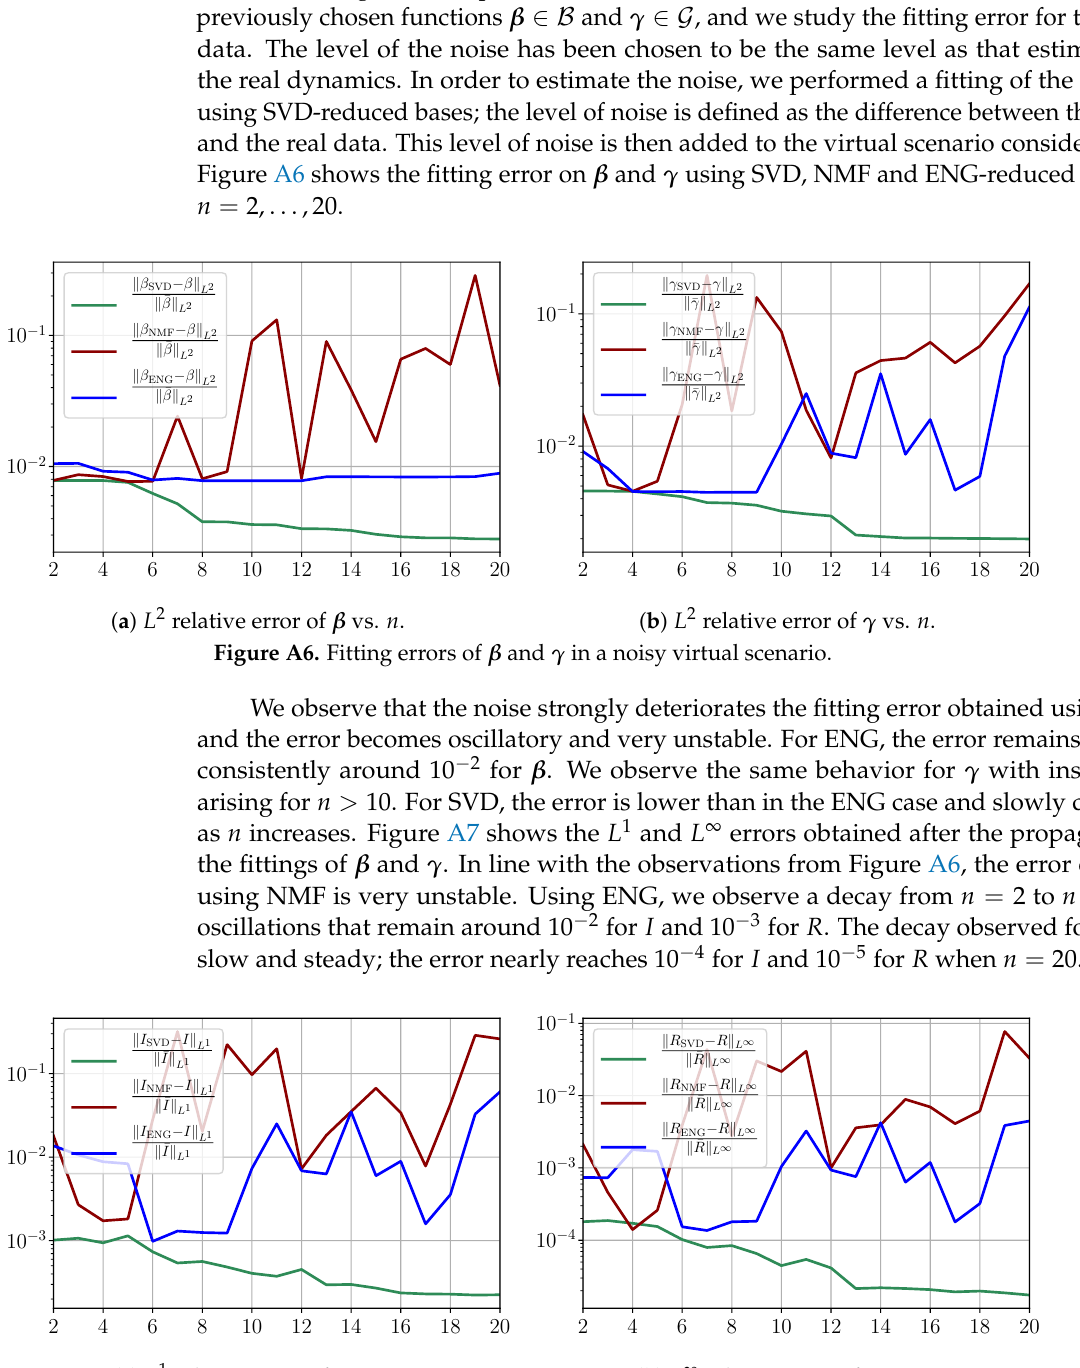
( b ) L ∞ relative error of R vs. n . Figure A7. Fitting errors of I and R on noisy